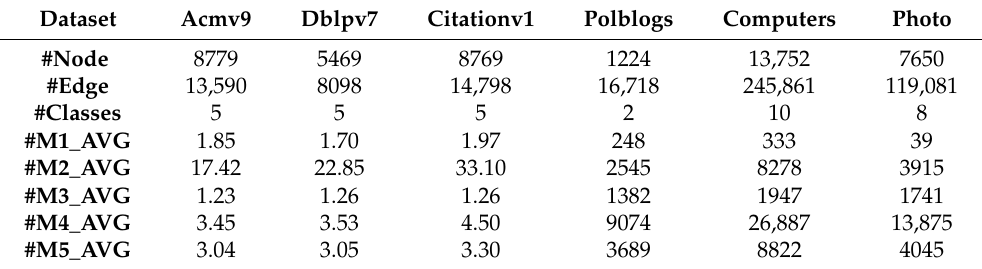
Table 3. Dataset statistics. “ #Node ” and “ #Edge ” represent the total number of nodes and edges. “ #Classes ” is the number of node types. “ #M1_AVG ”~” #M2_AVG ” represent the average number of motifs with per node in the motifs with id 1~5 in Table